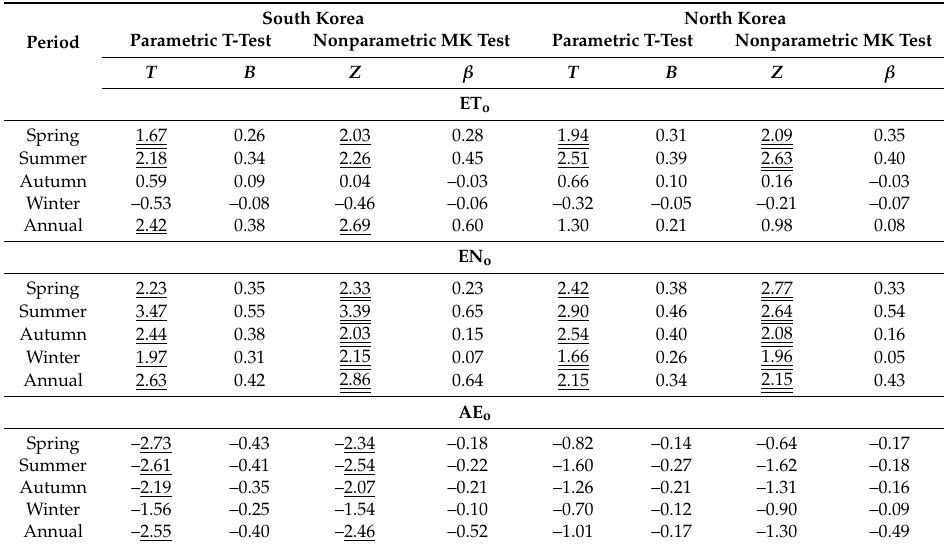
Table 3. Statistical trends in the seasonal and annual ET o , EN o , and AE o from 1980 to 2017.